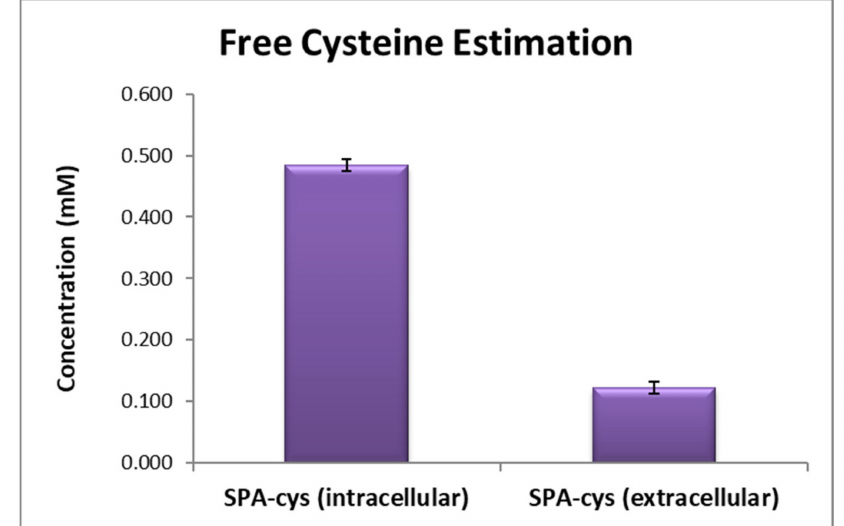
Figure 4. The bar graph showing the concentration of free cysteine available in purified samples for SPA-cys produced intracellular and extracellularly estimated by Ellman’s reagent.